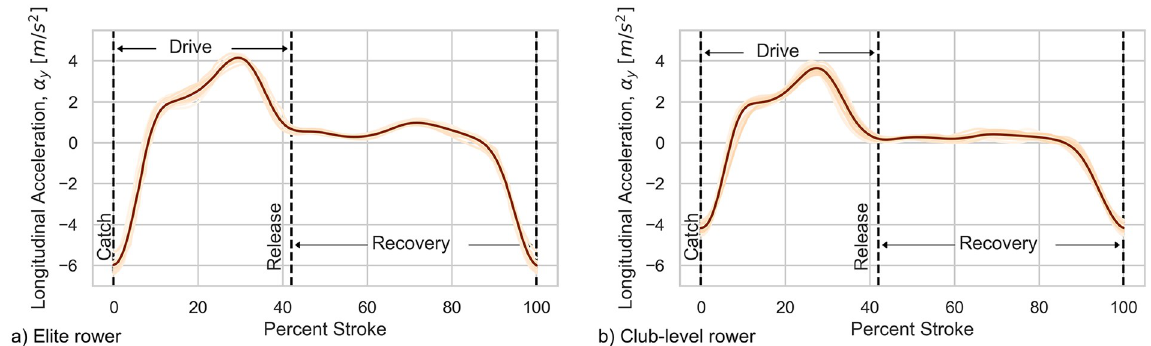
Fig 3. Boat-fixed longitudinal acceleration as a function of percent stroke from two trials (elite and club-level 24SE.). Each stroke is plotted as an orange line and the mean of all strokes as a dark line. The repeatability of the measured longitudinal acceleration, especially for the elite rower, validates the consistency of rowing technique, the robustness of the stroke endpoint identification, and the quality of the accelerometer data itself.